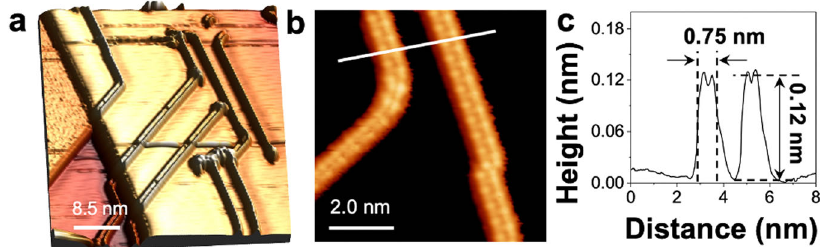
Fig. 1 Formation of P chains from the early stage of growth. a 3D view of the STM topographic image of P chains on the Ag(111) surface, showing atomically fl at terraces and P chains (46 × 46 nm 2 , U = − 800 mV, I = 1.50 nA). b High-resolution STM image of P chains on the Ag(111) (7 × 7 nm 2 , U = − 80 mV, I = 1.50 nA). c Line pro fi le measured along white line in b shows that the P chains have a typical width of 0.75 ± 0.01 nm and a height of 0.12